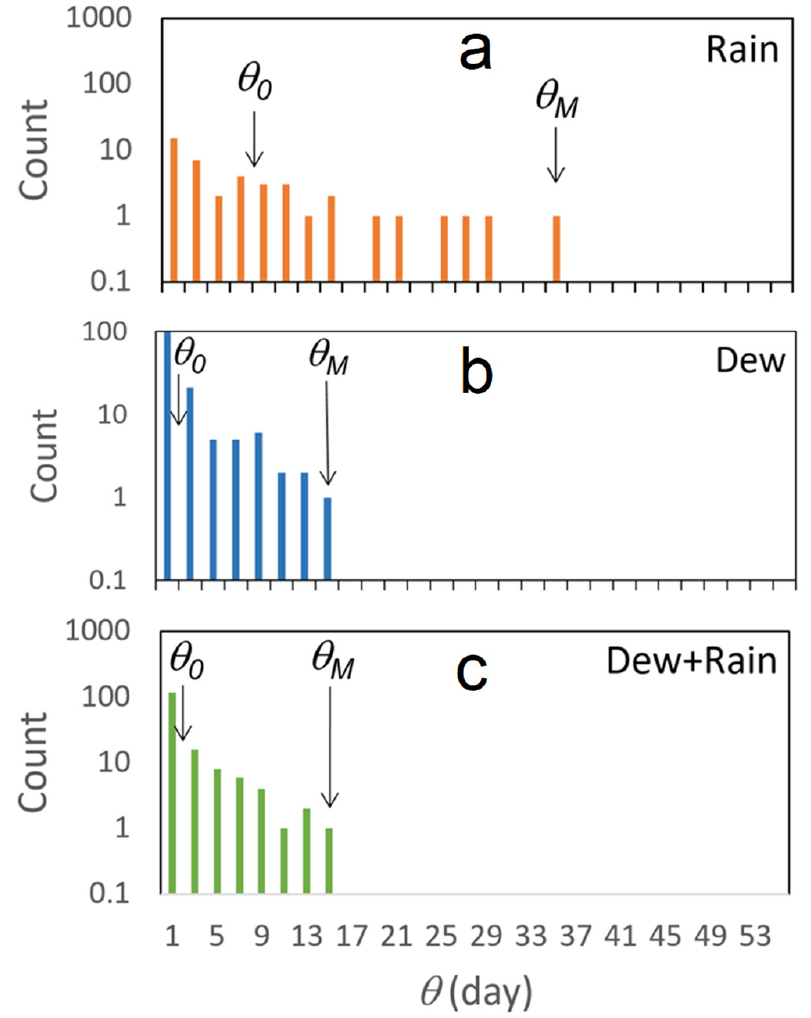
Figure 10. Typical histograms of time period θ (day) between ( a ) rain events, ( b ) dew events ( c ) rain plus dew events, for the Fuerte Ventura site (Year 2010). θ 0 is the mean time and θ M is the maximum time between events. Note that some dew or rain events can disappear in the histogram dew + rain because dew or rain events can occur during the dew or rain time periods. Table 5. Yearly mean, minimum and maximum values for maximum time θ M and mean time θ 0 (days) between events, considering all sites and according to both RCP scenarios between years 2006 and 2100.